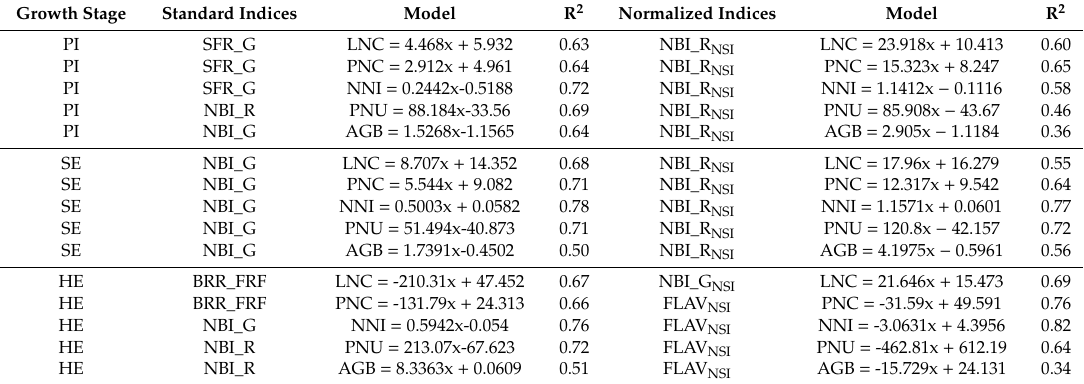
Table 5. Equations and coe ffi cients of determination of linear regression models (n = 40) at di ff erent growth stages based on the best performing Multiplex index and crop N indicators (LNC, PNC, NNI, PNU, and